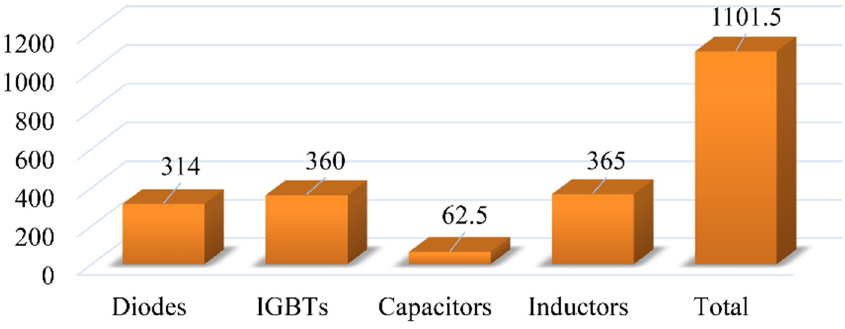
Figure 15. Power loss